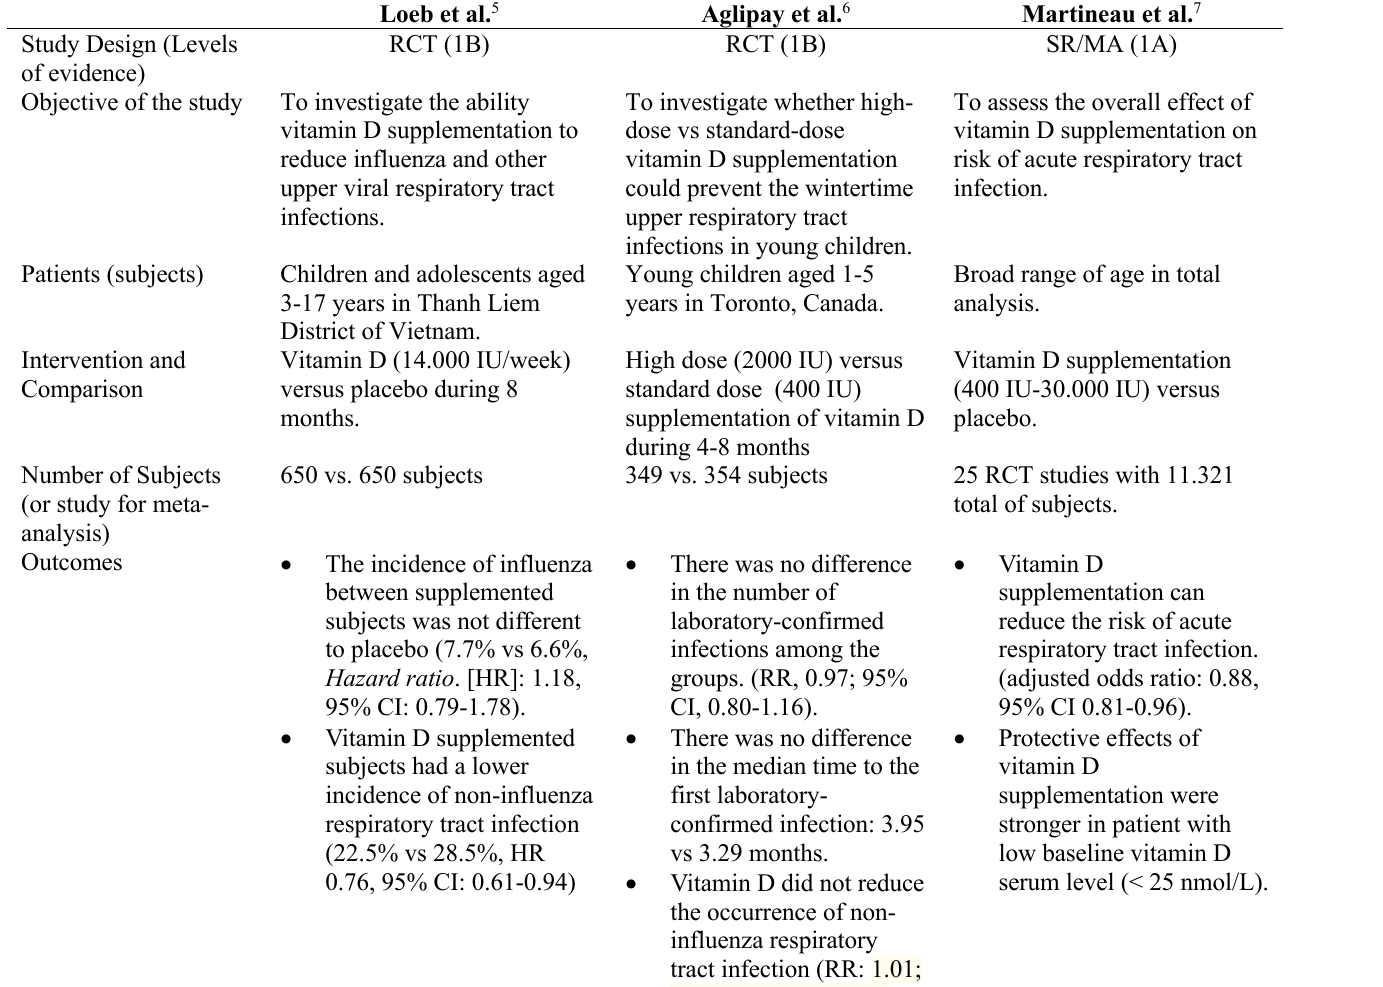
Table 2. Characteristics of each